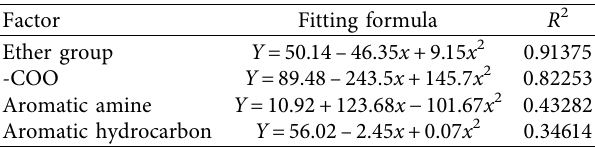
Table 8: Nonlinear correlation analysis of surfactant functional groups and